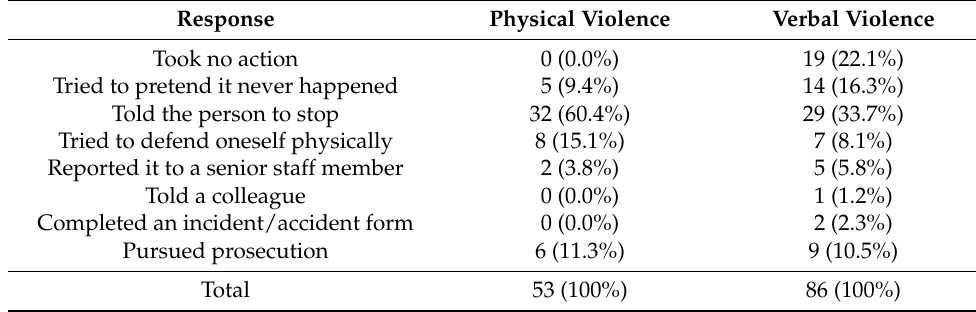
Table 3. Participants of healthcare workers towards physical and verbal WPV.